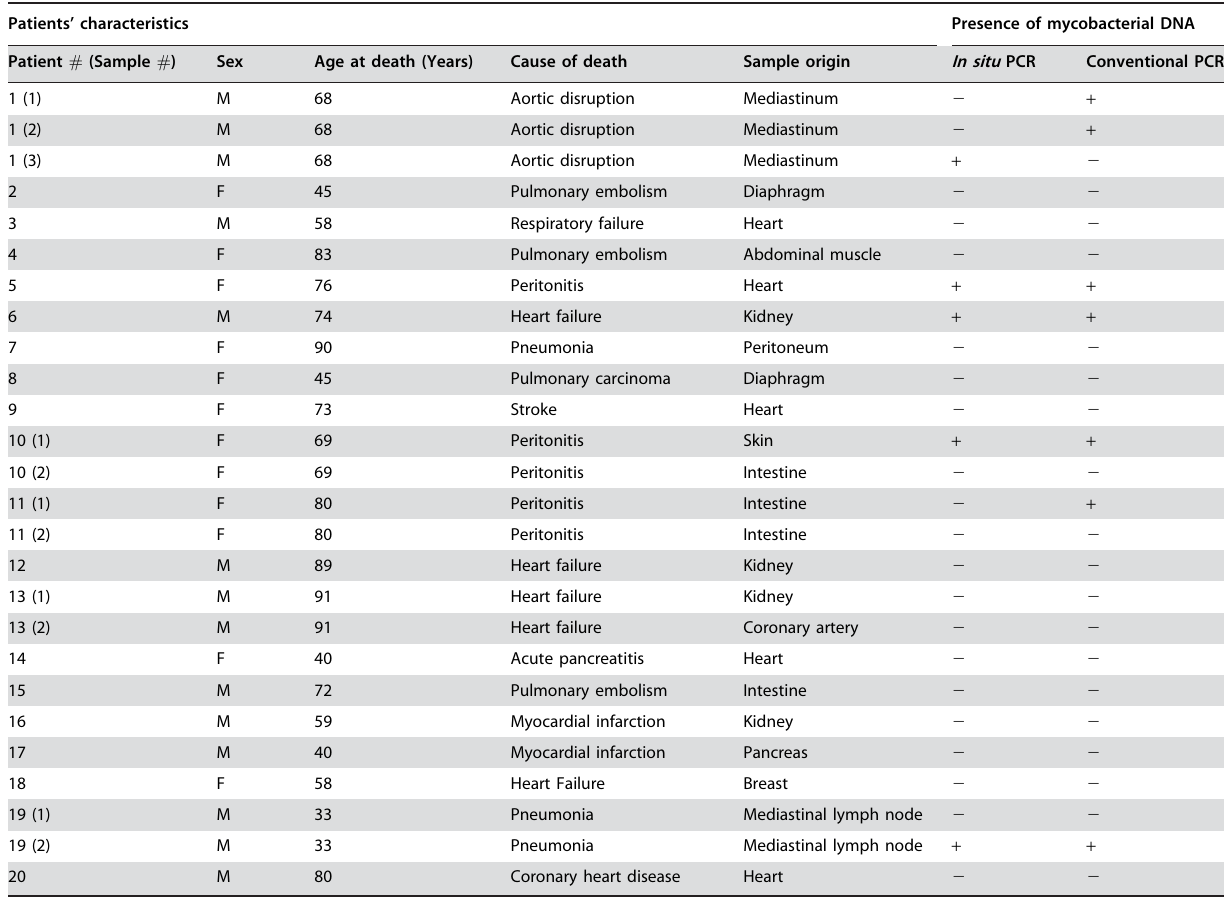
Table 2. Detection of M. tuberculosis DNA in adipose tissue from French autopsy samples a .. ... .... ... ... .... ... ... .... ... ... .... ... ... .... ... ... .... ... ... .... ... ... .... ... ... .... ... ... .... ... ... .... ... ... .... ... ... .... ... ... .... ... ... . Patients’